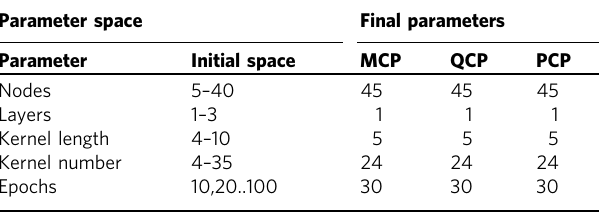
Table 2 Hyper-parameters search for whole-library models.